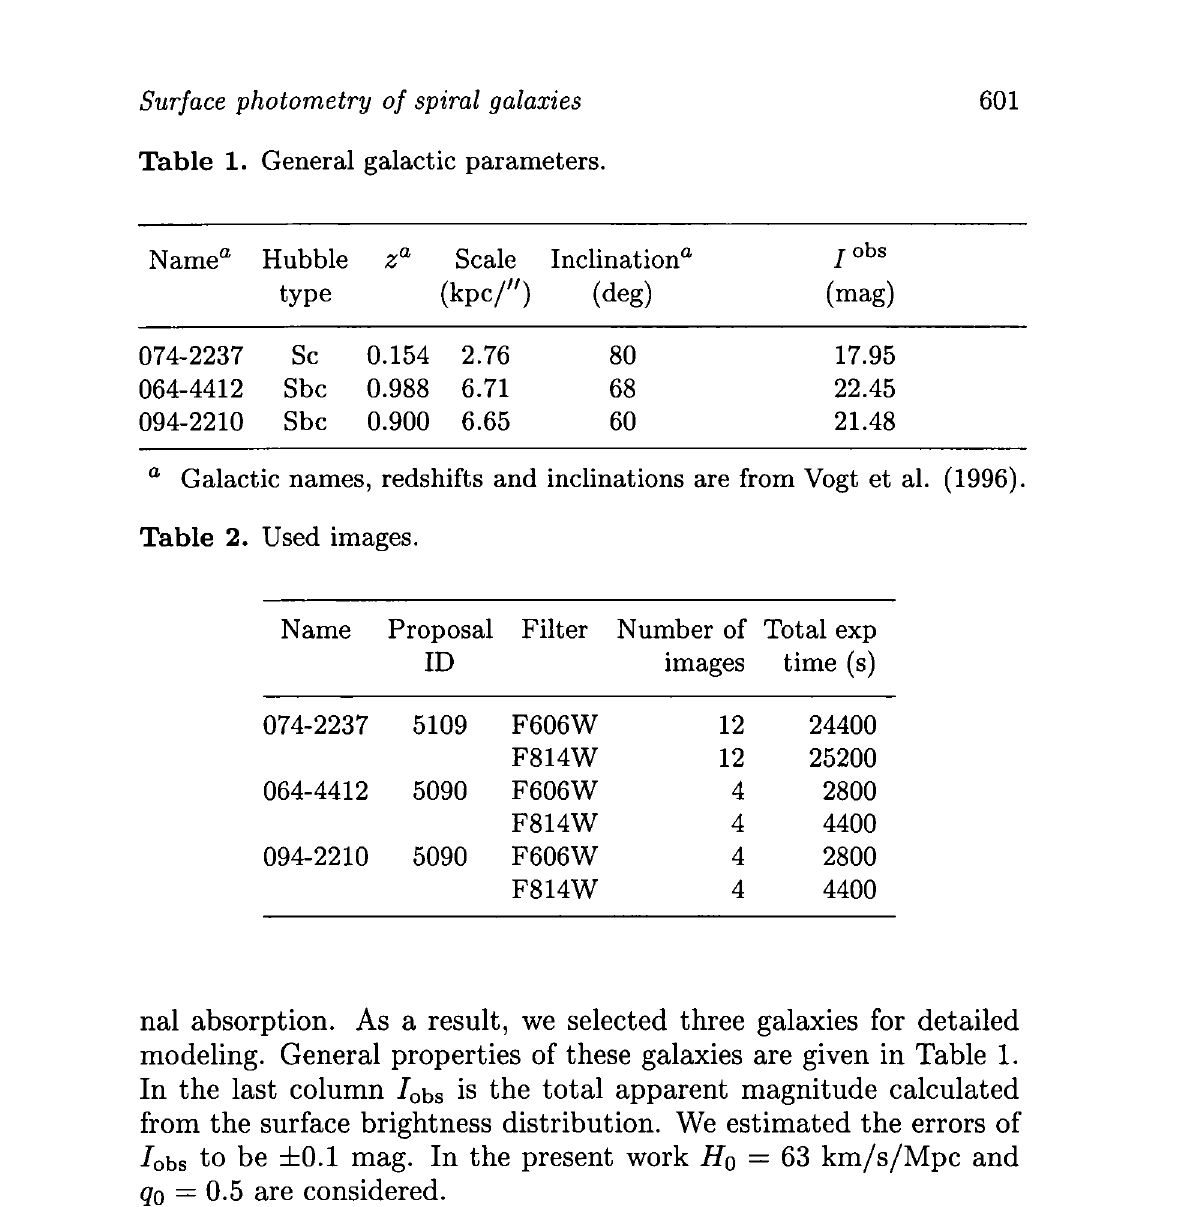
Table 1. General galactic